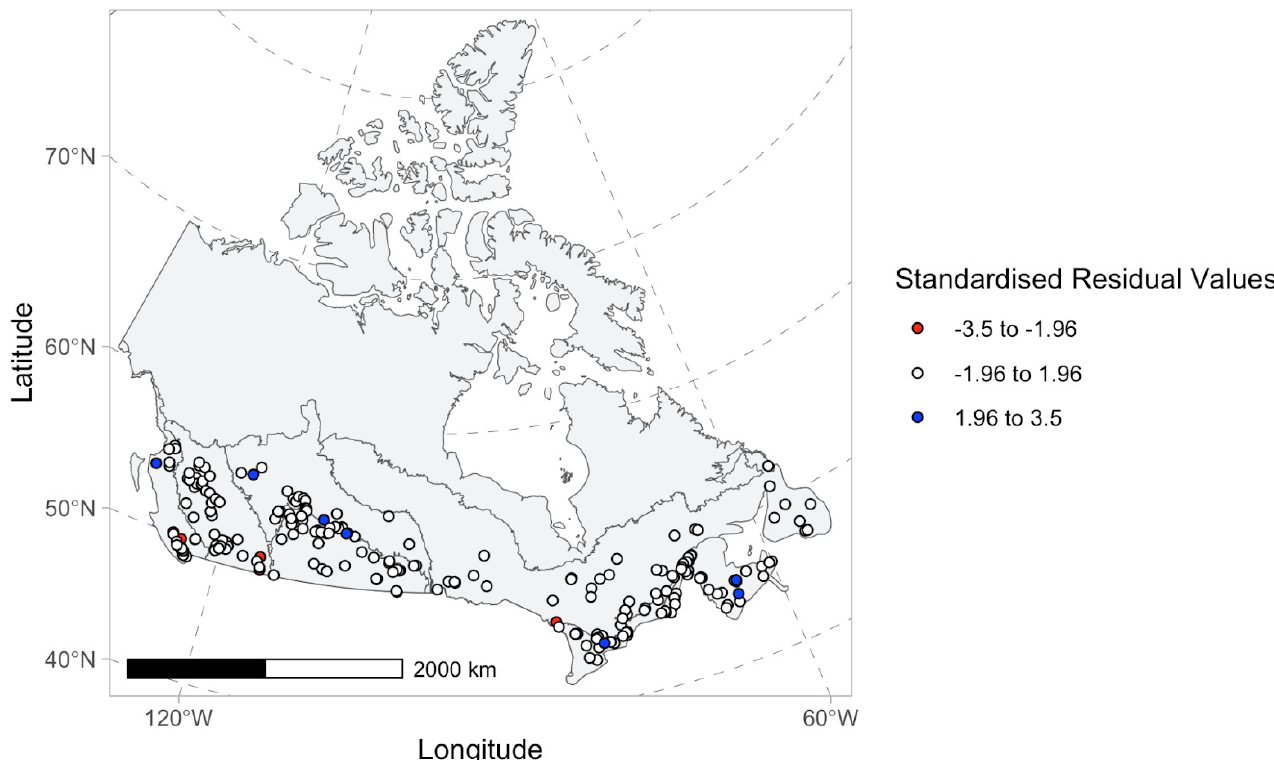
Figure 3. Map of standardised residuals for global regression model between in situ coloured dissolved organic matter (CDOM) and Landsat 8 B3/B4 and B2 for data obtained within a 30-day window of each other.